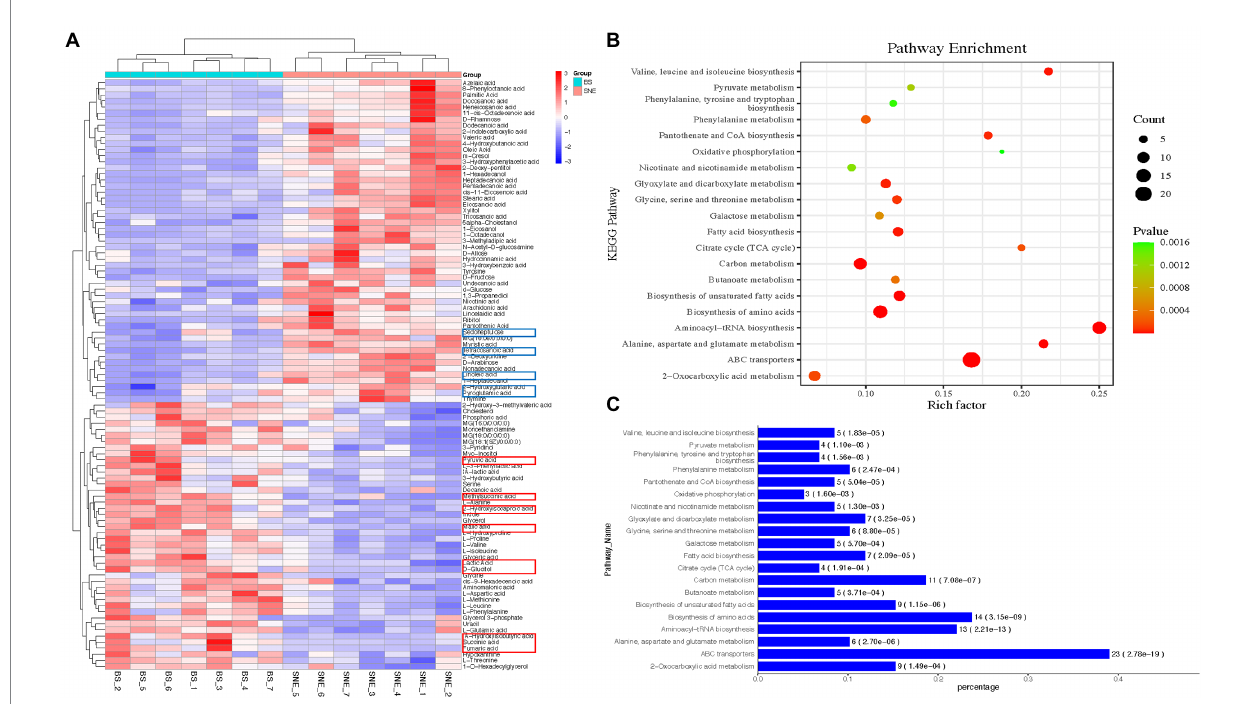
FIGURE 9 (A) Heat map of the significantly differentially-abundant metabolites between the BS group and the SNE group (VIP >1 and p < 0.05). A row presents the data obtained from a metabolite, and a column represents one sample. Red and green correspond to the increased and decreased levels of the metabolites, respectively; Bubble (B) and bar (C) charts of top 20 most enriched KEGG pathways. p -values are determined using two-tailed Student’s t -tests. SEM, standard error of mean. Each value represents the mean ± SEM of 7 replicates ( n = 7). The abbreviation of SNE and BS have the same meaning as Table